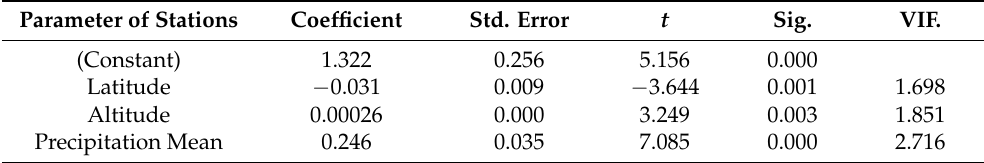
Table 5. Results of a linear regression of the prediction accuracy of TMPA data based on station